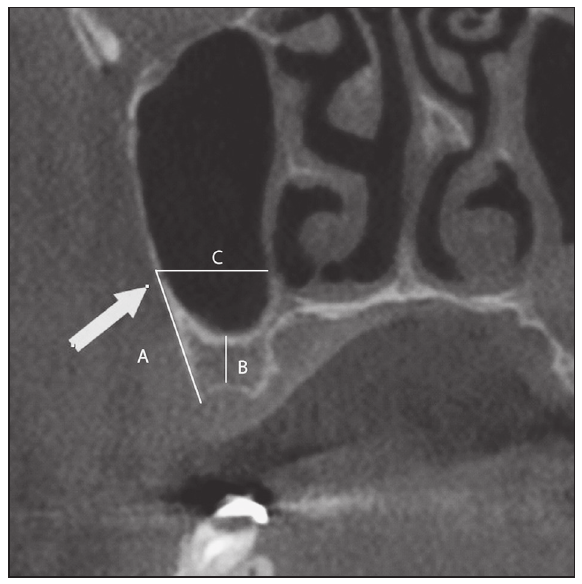
Figure 1- Distance between the lower border of the artery and the alveolar crest ( A ), bone height from the sinus floor to the ridge crest ( B ), and distance from the artery to the medial sinus wall ( C